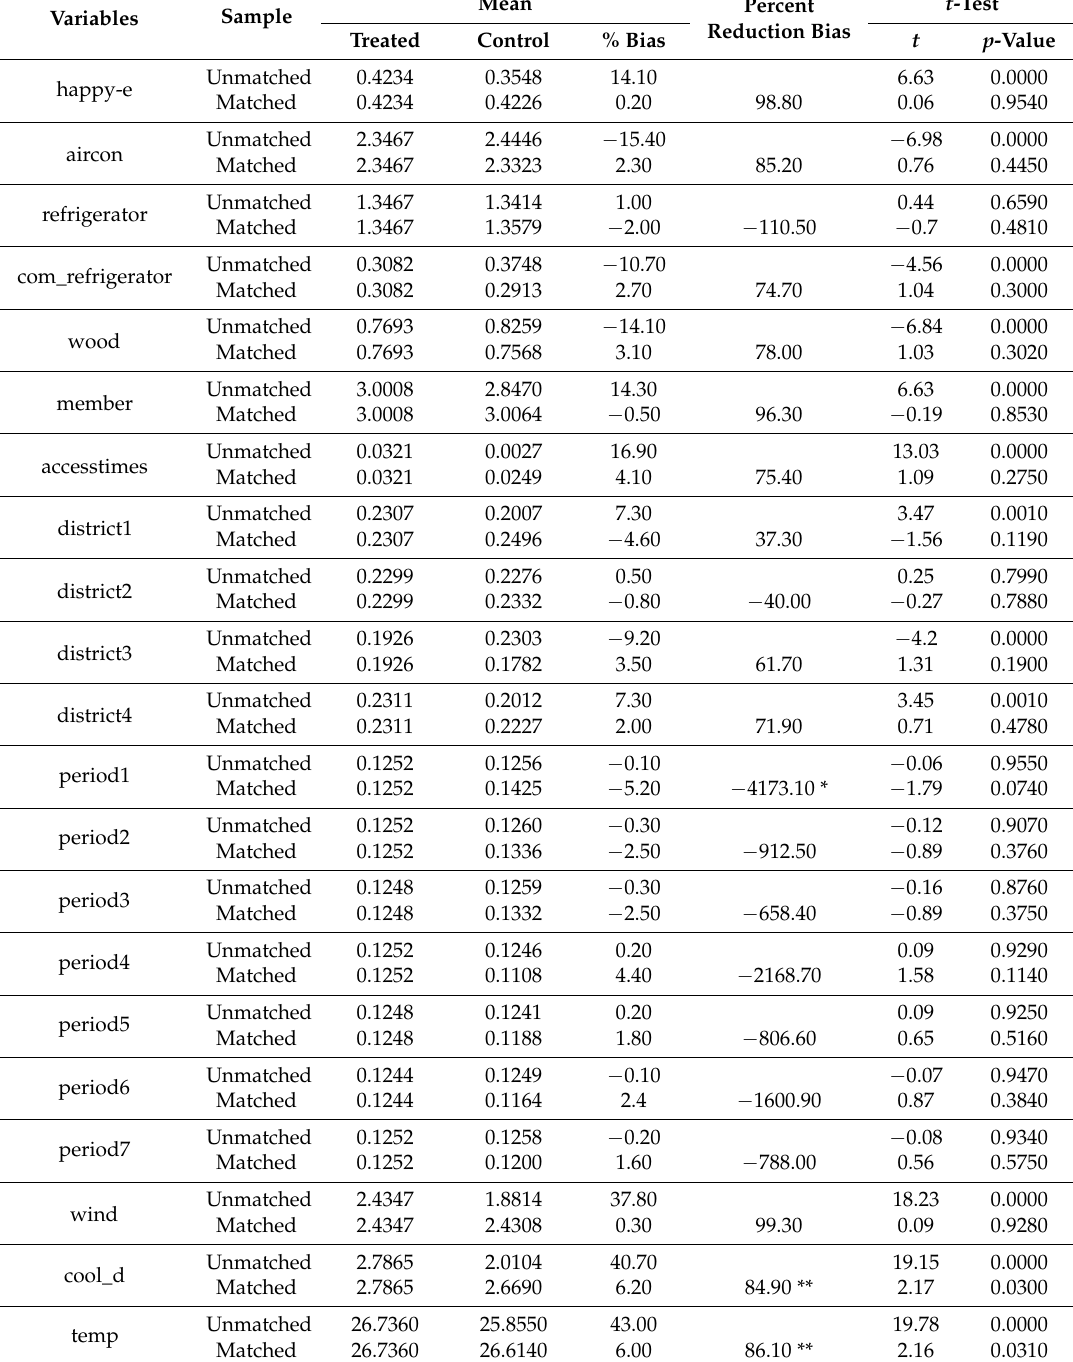
Table A2. Result of balancing test of propensity score model of Dum_20_elas